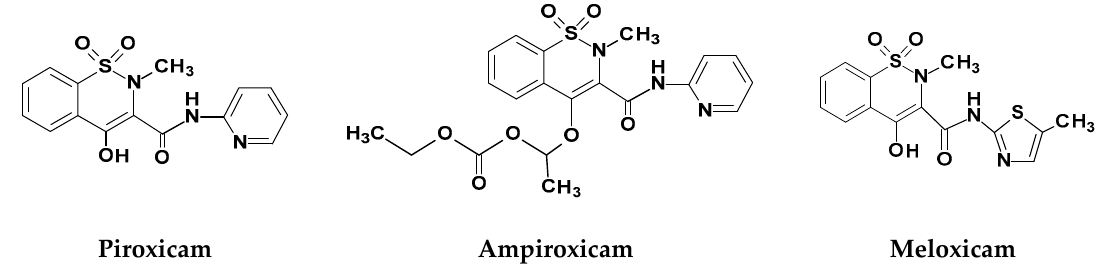
Scheme 1. Structures of selected 1,2-benzothiazine-based